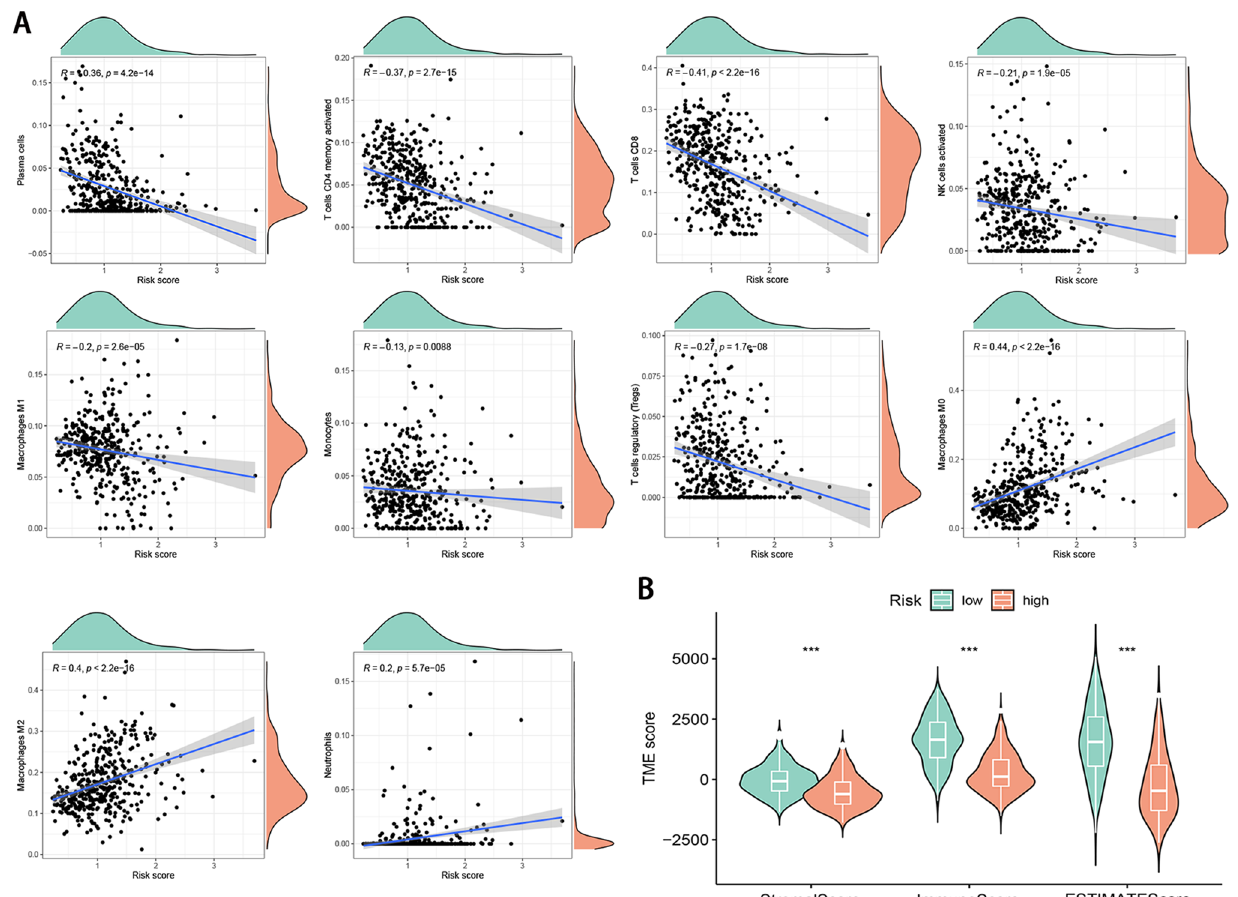
Figure 4. Immune landscape between low- and high-risk groups. ( A ) The infiltration levels of 22 immune cell types in the two risk groups. ( B ) The relationship between signature and the TME